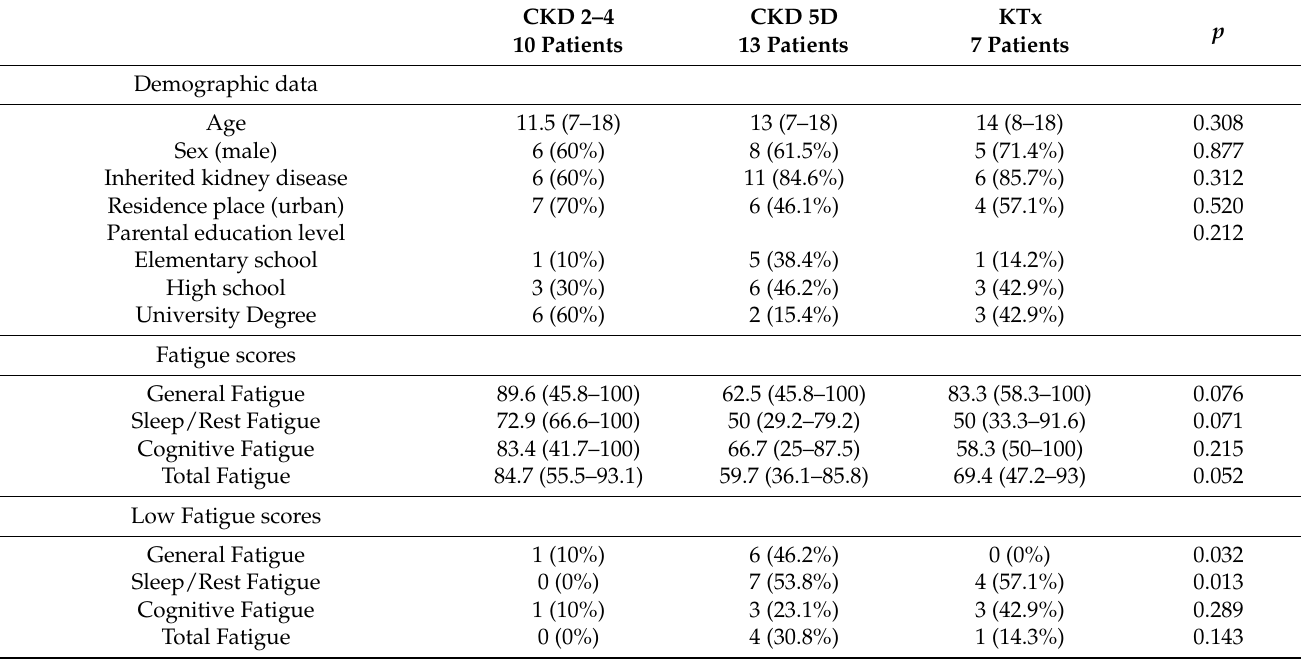
Table 1. Distribution of scores regarding fatigue and Health Related- Quality of Life (HRQoL) and their subcategories in pediatric patients with chronic kidney disease (CKD) stage 2–4, CKD stage 5 on chronic dialysis (CKD 5D), and kidney transplantation (KTx). Continuous data are presented